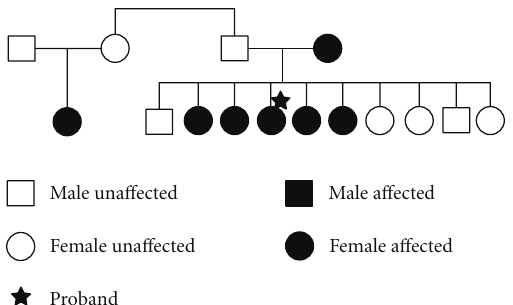
Figure 1: Pedigree of patient’s family with 7 a ff ected individuals across 2